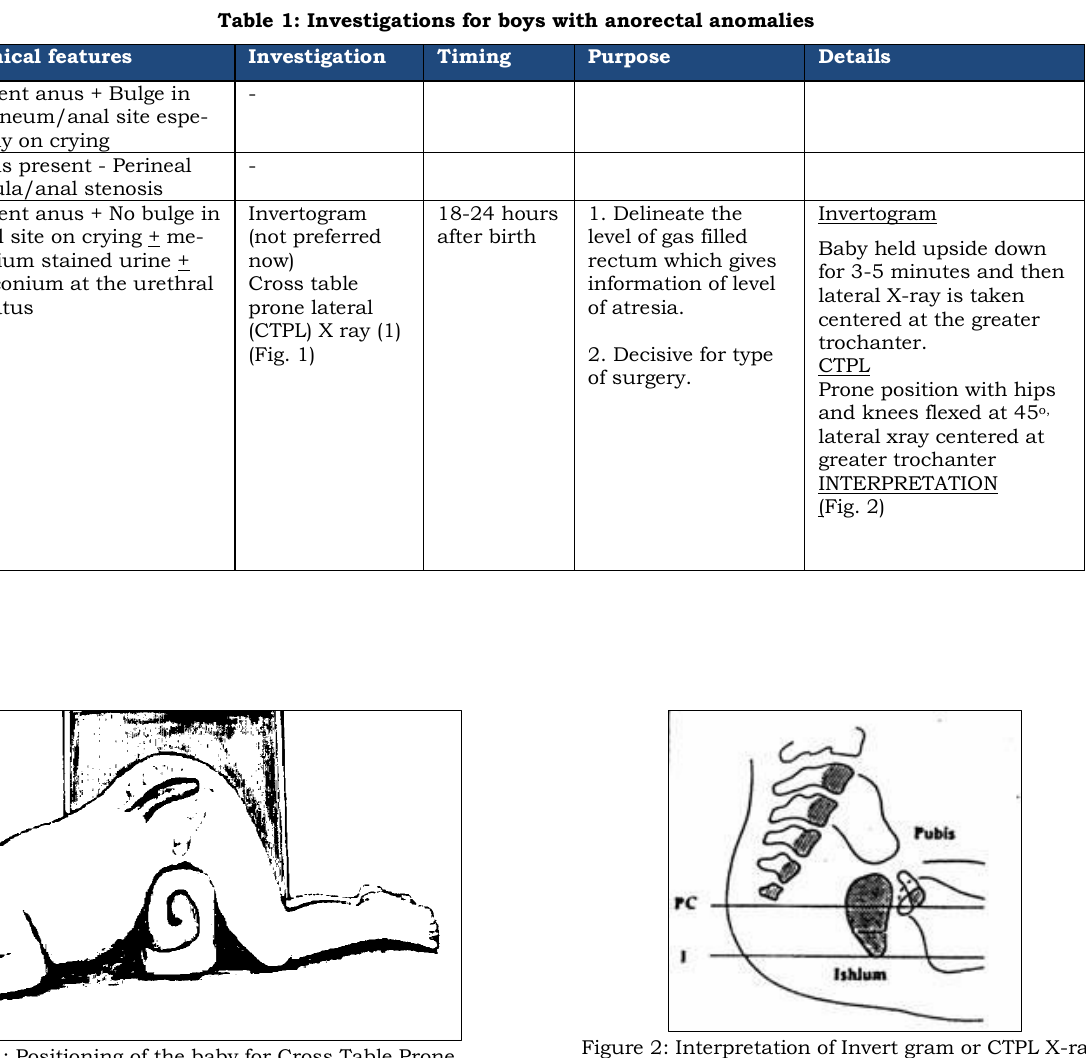
Figure 1: Positioning of the baby for Cross Table Prone Lateral X-Ray.